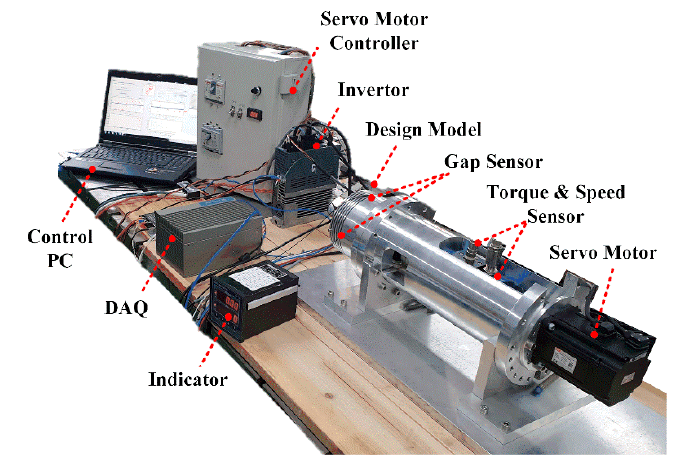
Figure 10. Vibration measurement system of the PMSM.